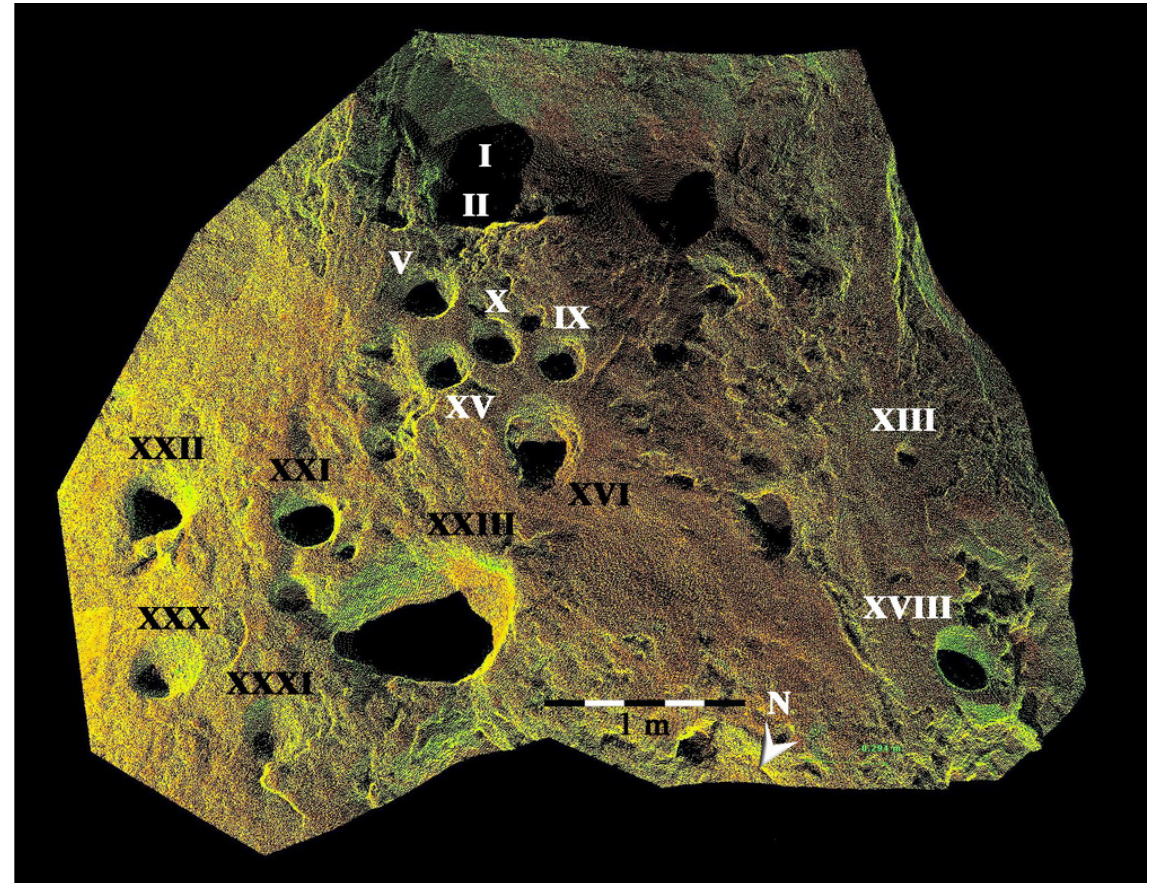
Figure 2. A panoramic view of the first chamber floor of Raqefet Cave, with location of bedrock mortars mentioned in the text (prepared from a 3D model, courtesy of S.